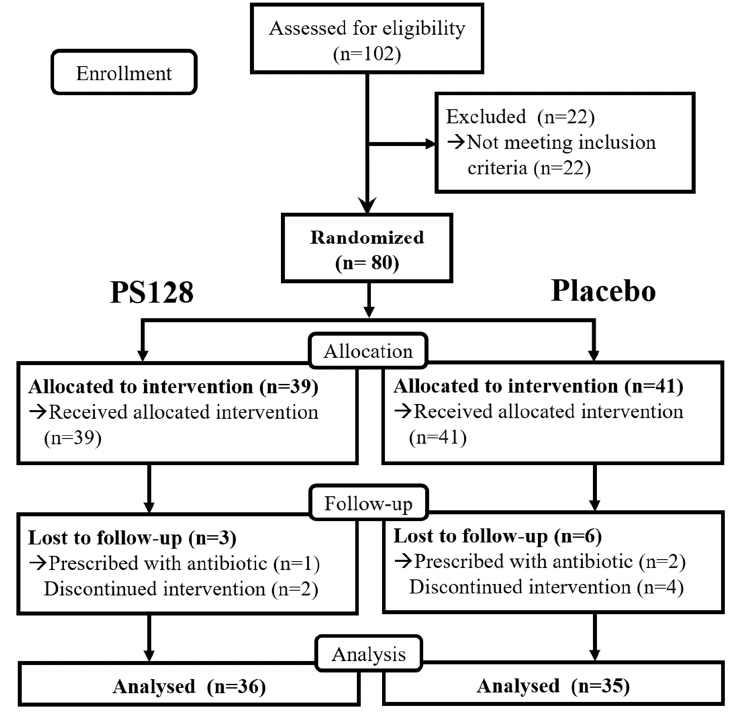
Figure 1. Trial profile.